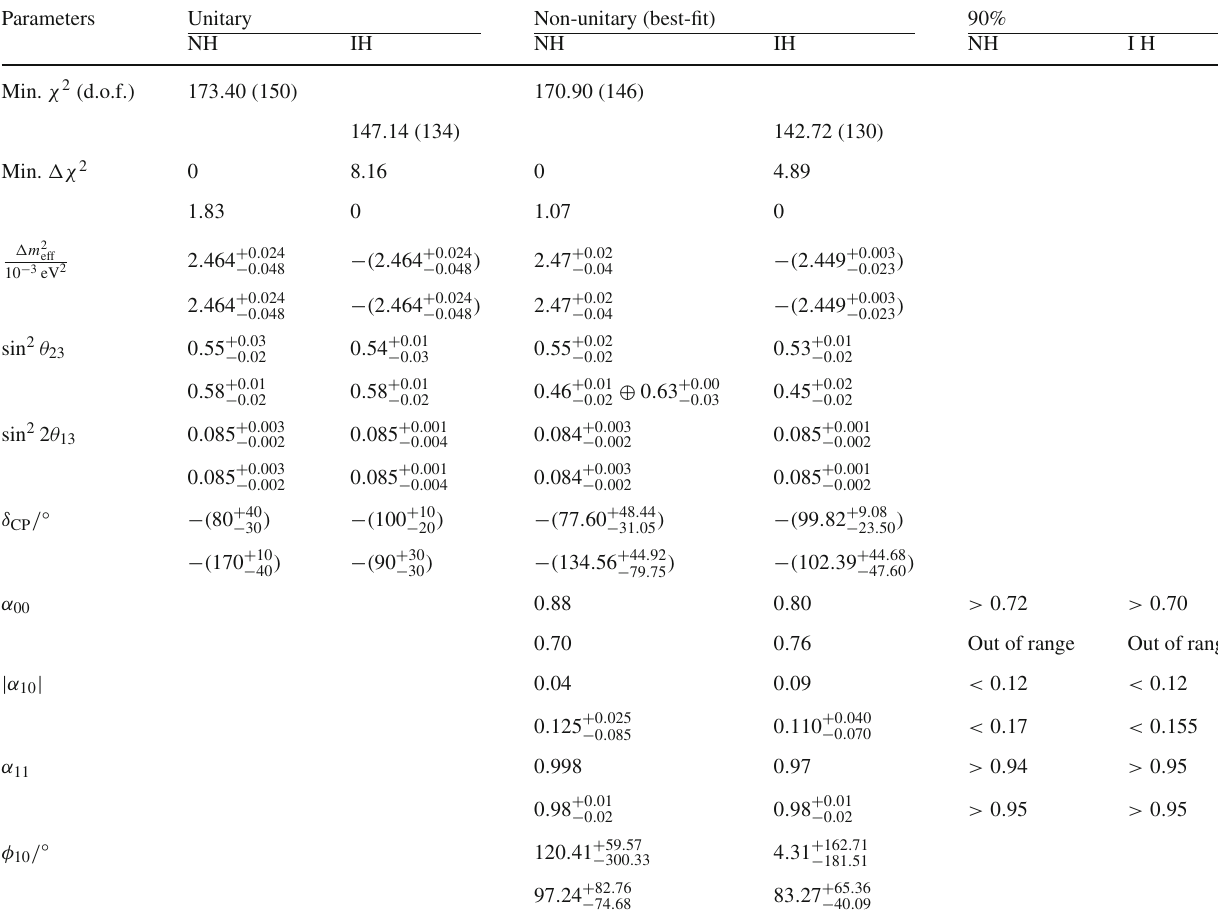
Table 3 Parameter values at the best-fit points for the combined anal- ysis of NO ν A and T2K.The 1 σ error bars have been mentioned where possible. The 90% limits for 1 d.o.f have also been mentioned. In each